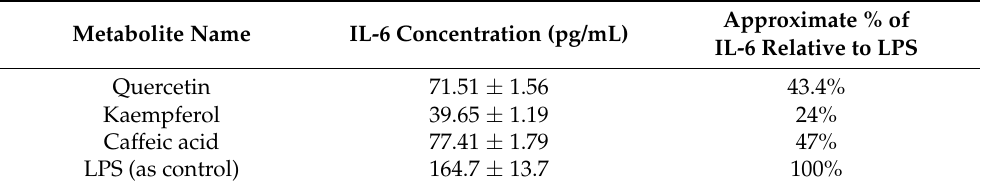
Table 3. The effect of Moringa metabolites viz. quercetin, kaempferol, and caffeic acid on the proinflammatory cytokine IL-6.